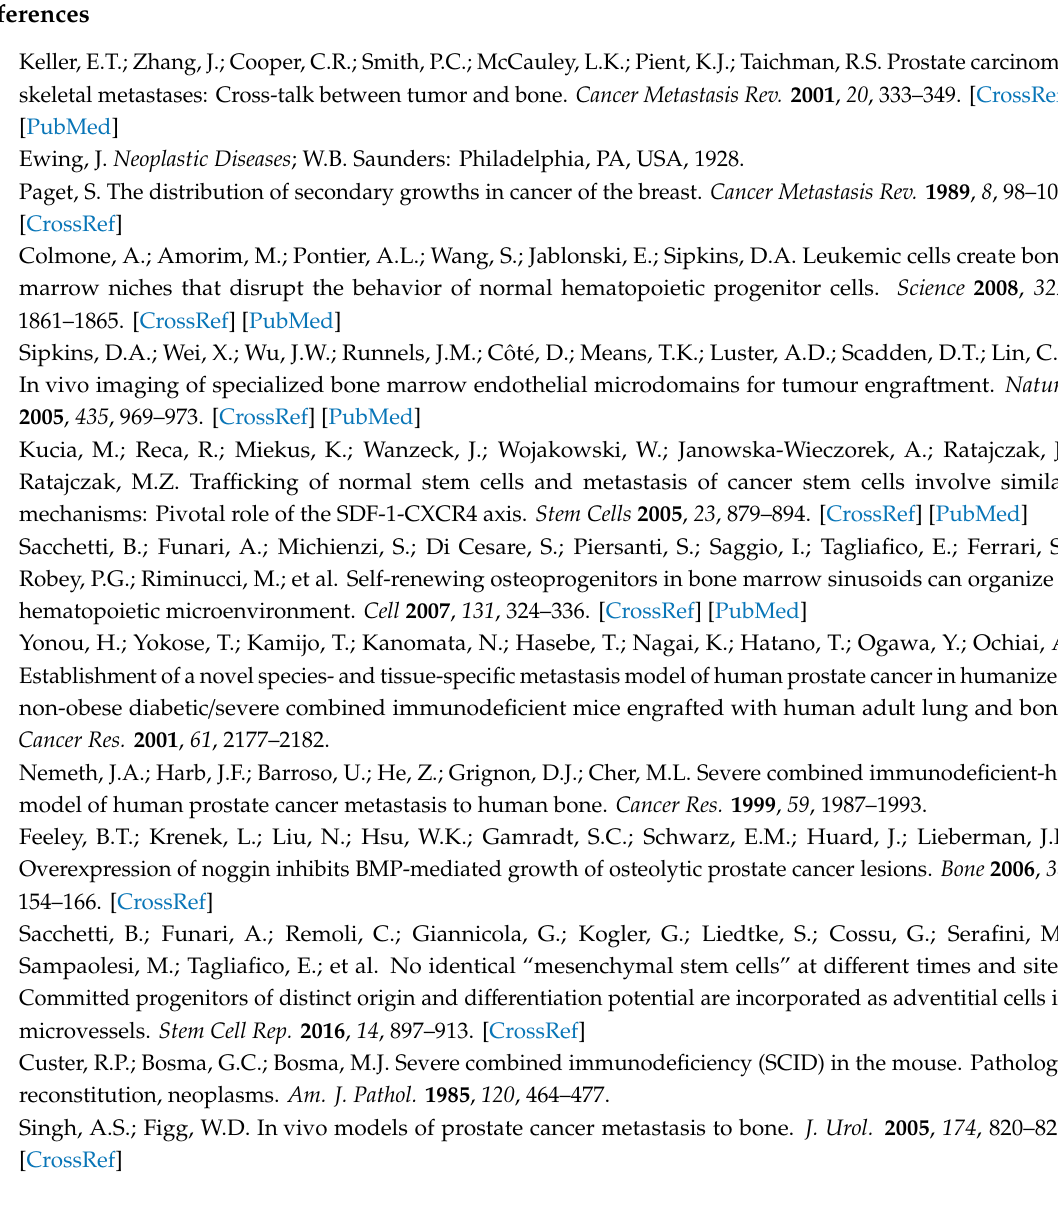
Figure S1: Early stages of prostate cancer metastases to humans bone